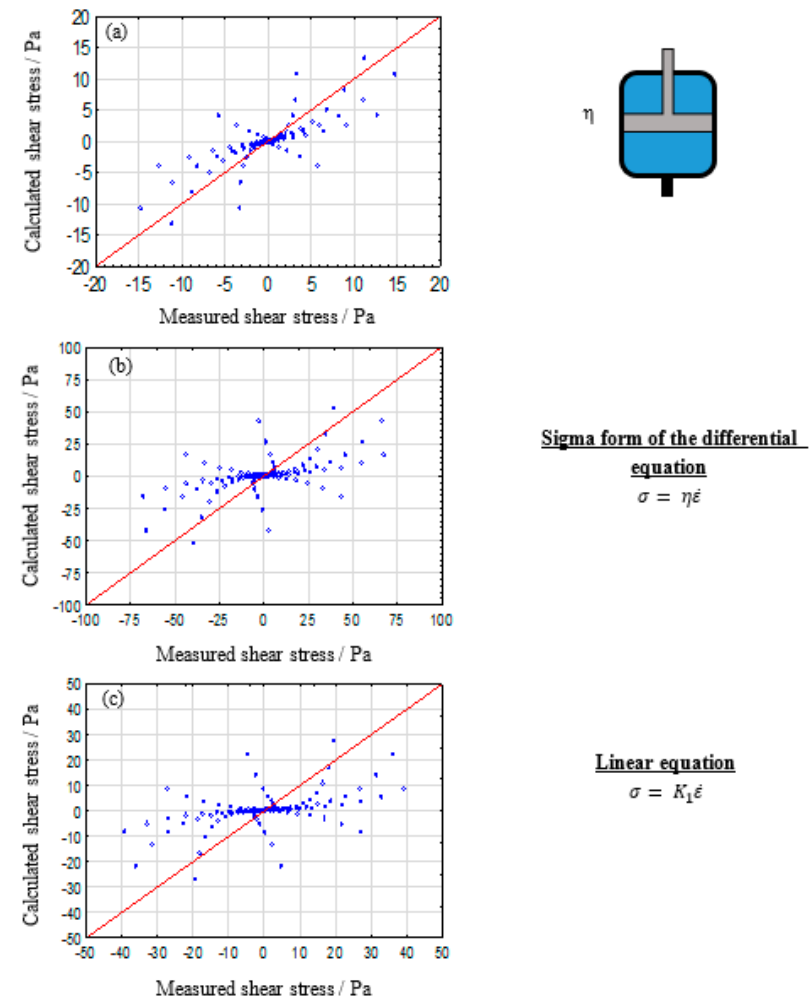
Figure 2. Calculated vs. measured shear stresses plot for a single dashpot for describing the viscoelastic properties of 2% ( a ), 5% ( b ), and 8% ( c ) alginate solutions .